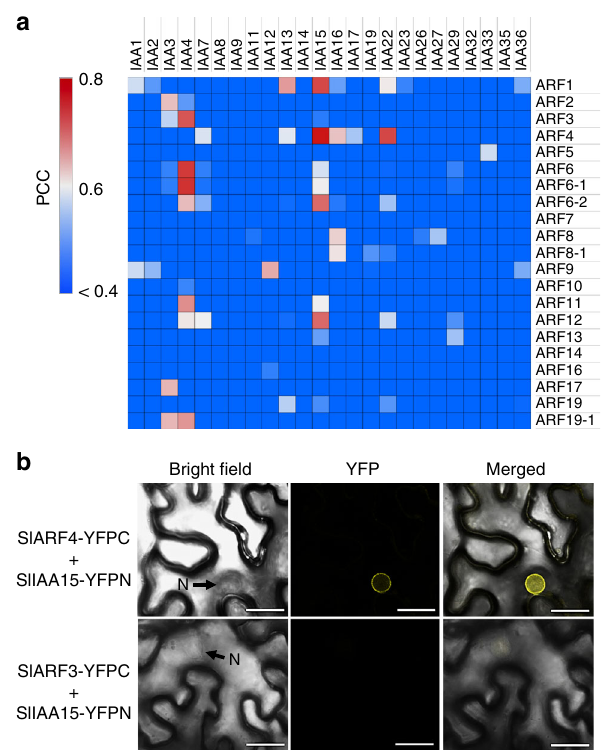
Fig. 3 Identifying protein interactions between spatiotemporally co- expressed ARF and Aux/IAA auxin signaling associated proteins. a Heat map showing pairwise correlation scores between auxin signaling related ARF and Aux/IAA genes across the analyzed fruit tissues and cells during development. Pearson correlation coef fi cient (PCC) values were calculated for each pair of ARF - Aux / IAA genes. b SlARF4 interacts with SlIAA15 in planta. BiFC analysis in N. benthamiana leaf epidermal cells expressing full length of SlARF4 and SlIAA15 fused to the amino (YFPN) or carboxyl (YFPC) portions of YFP. Yellow fl uorescence indicates interaction between SlARF4- YFPC and SlIAA15-YFPN. No clear interaction was detected between SlARF3-YFPC and SlIAA15. N, Nucleus. Scale bars: 25 µ